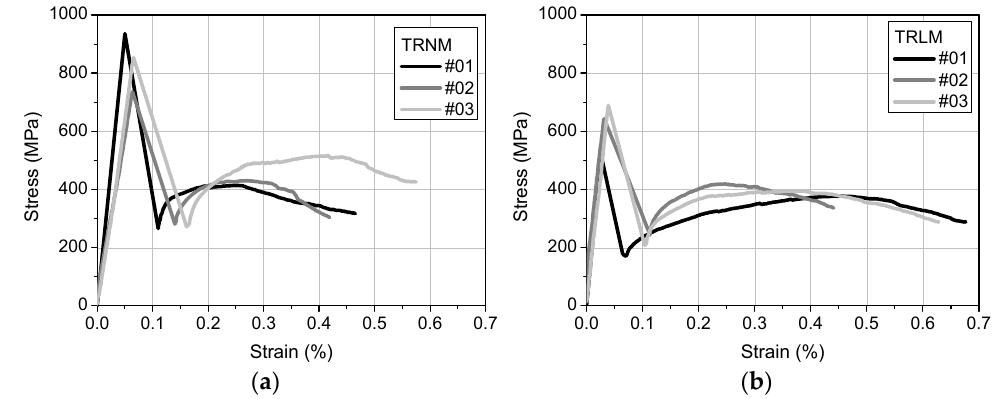
Figure 2. Axial tensile stress versus axial tensile strain curves of: ( a ) TRNM and ( b ) TRLM rectangular coupons.